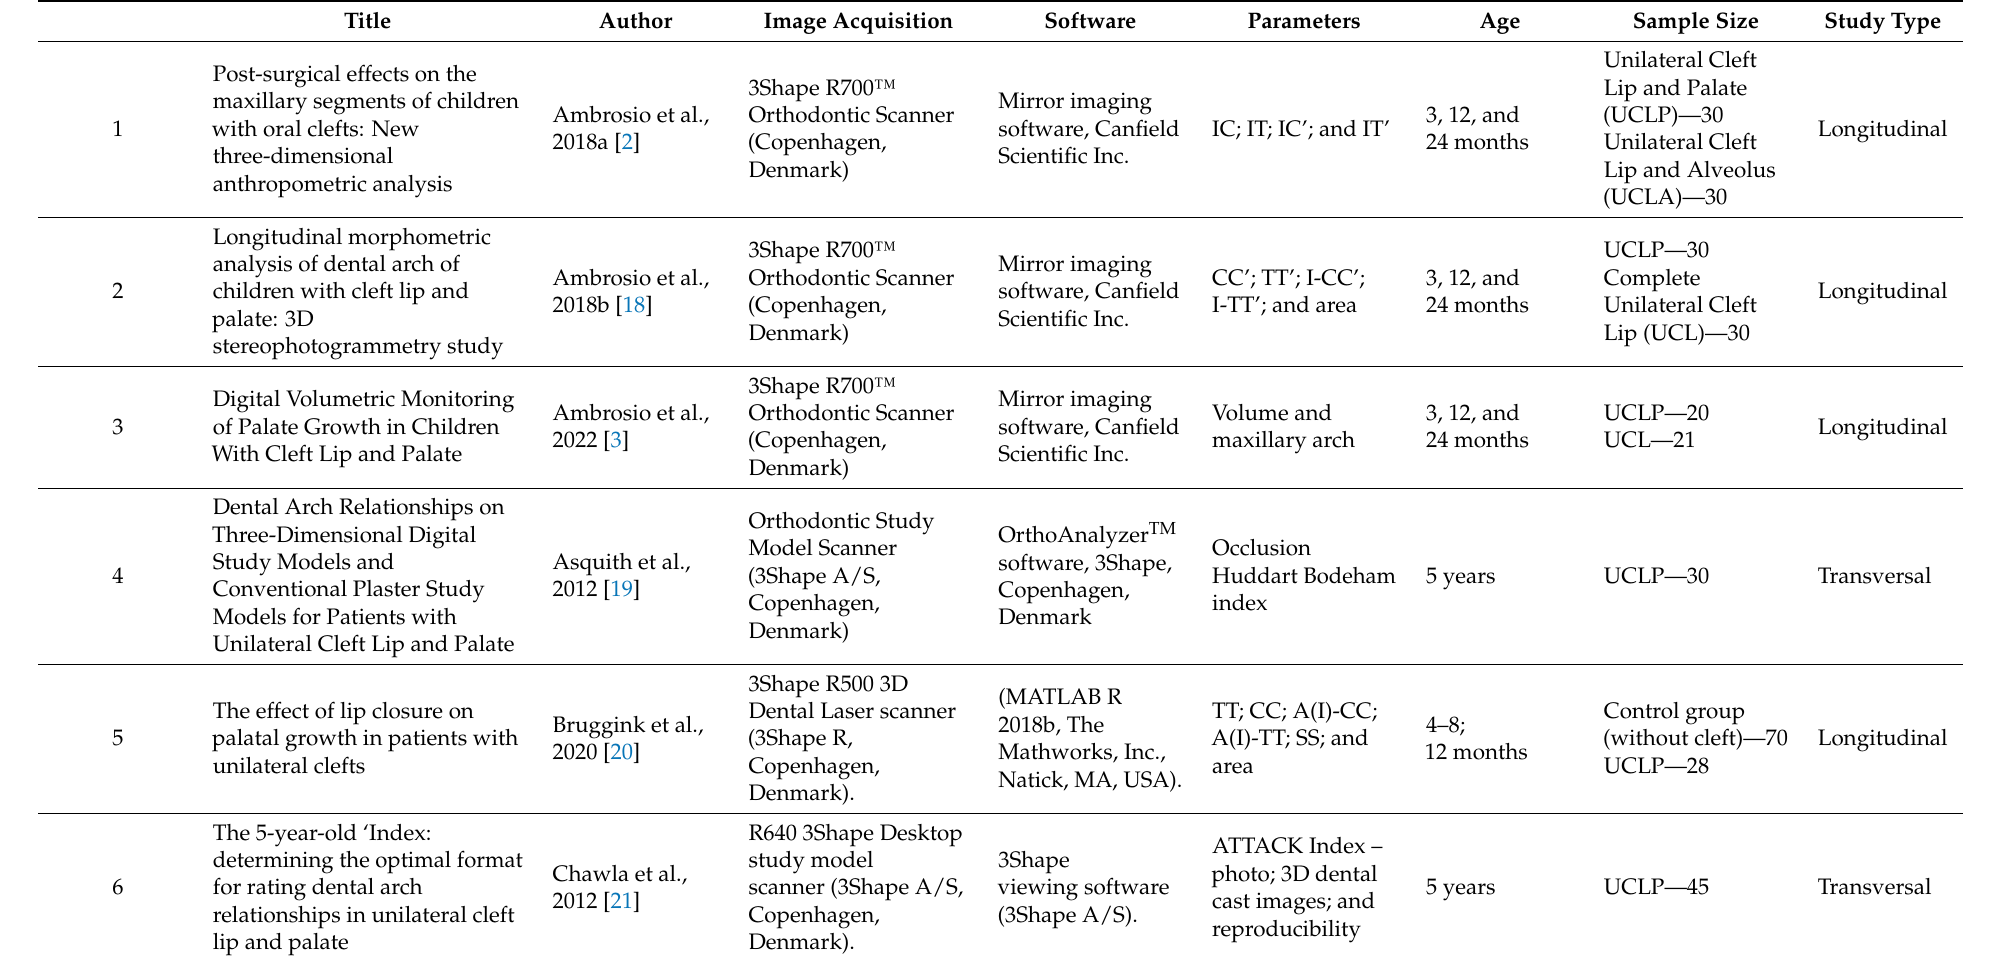
Table 1. Studies selected for the narrative